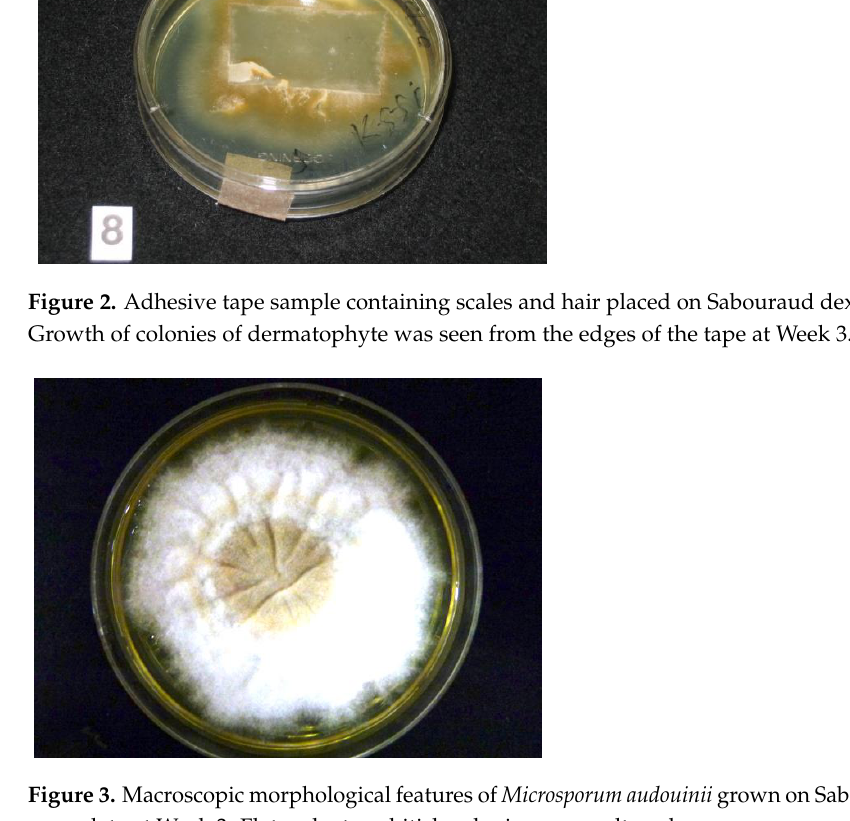
Figure 3. Macroscopic morphological features of Microsporum audouinii grown on Sabouraud dextrose agar plate at Week 3. Flat, velvety, whitish colonies were cultured.